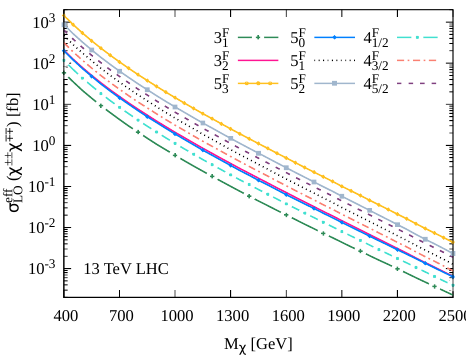
Figure 4 . Effective cross-section of doubly-charged pair production at LO in different simplified